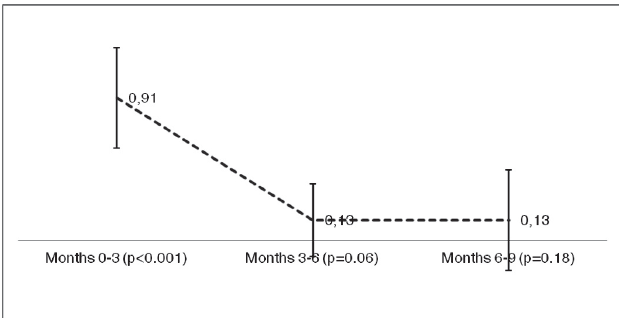
Fig. 2 - Average Changes of Saturation and Brightness during the study